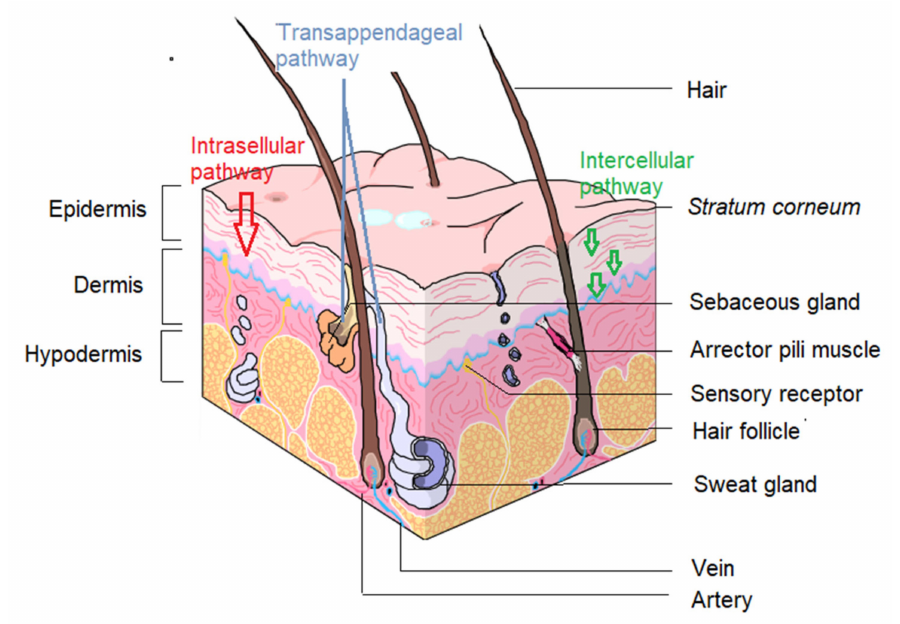
Figure 4. Dermal drug penetration pathways (adapted from [134]).